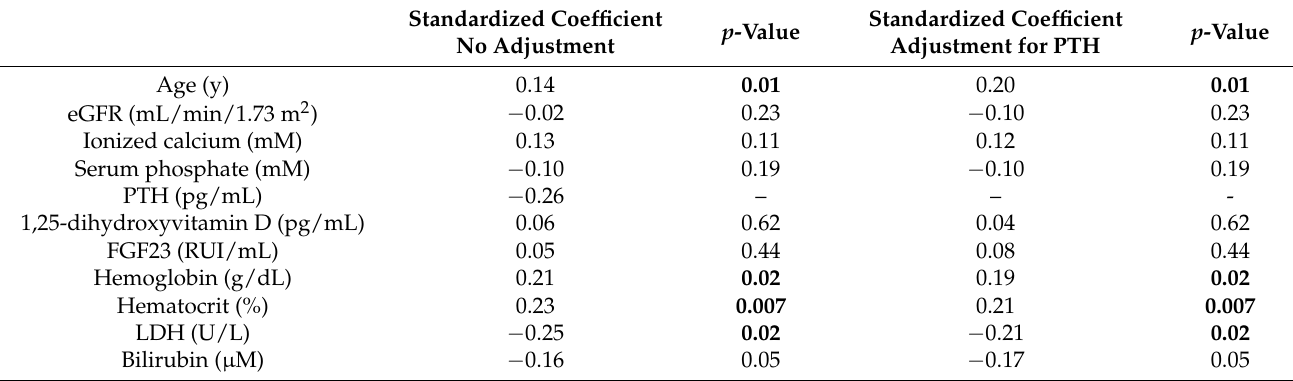
Table 2. Univariate analysis of biochemical factors associated with fasting FeCa 2+ in non-pHPT SCD patients, before and after adjustment on PTH. y, years; mM, mmol/L; µM, µmol/L. Standardized Coefficient